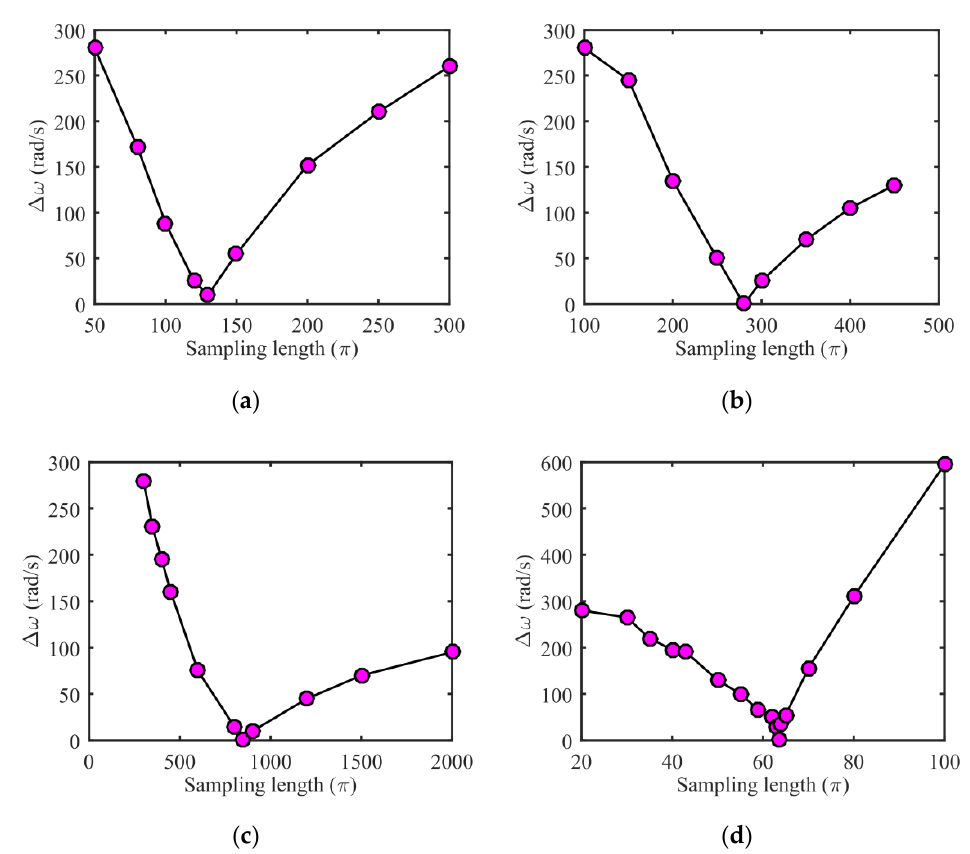
Figure 7. Relationships between the sampling lengths and the relatively errors of bifurcation points for the POMs with 2-DOFs at 4 different sampled rotational speeds: ( a ) 350 rad/s, ( b ) 500 rad/s, ( c ) 700 rad/s, ( d ) 1000 rad/s.